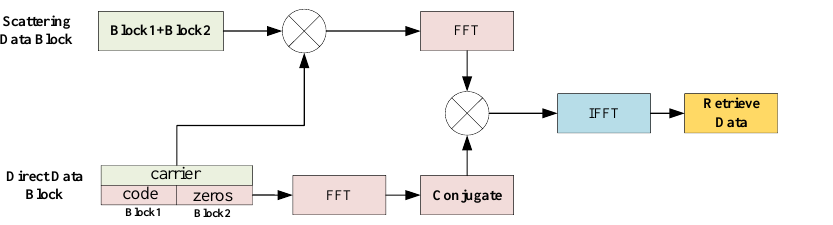
Figure 7. Schematic diagram of data compress.